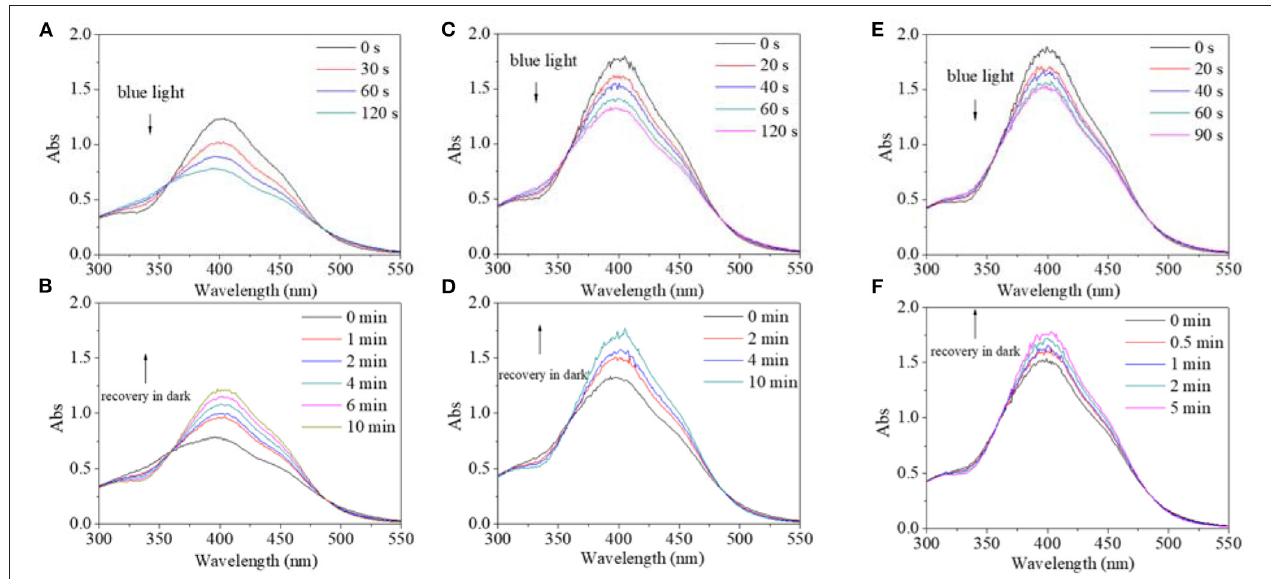
FIGURE 9 | UV spectra of PBLG2 solution with 20% alcohol (A,B) , 40% alcohol (C,D) , and 60% alcohol (E,F) as a function of irradiation time (A,C) and recovery time (B,D) . Irradiation was performed under blue light, and recovery process was performed under darkness and room temperature. Polymer concentration was 0.65 mg/mL for (A,B) , 0.91 mg/mL for (C,D) , 0.96 mg/mL for (E,F)